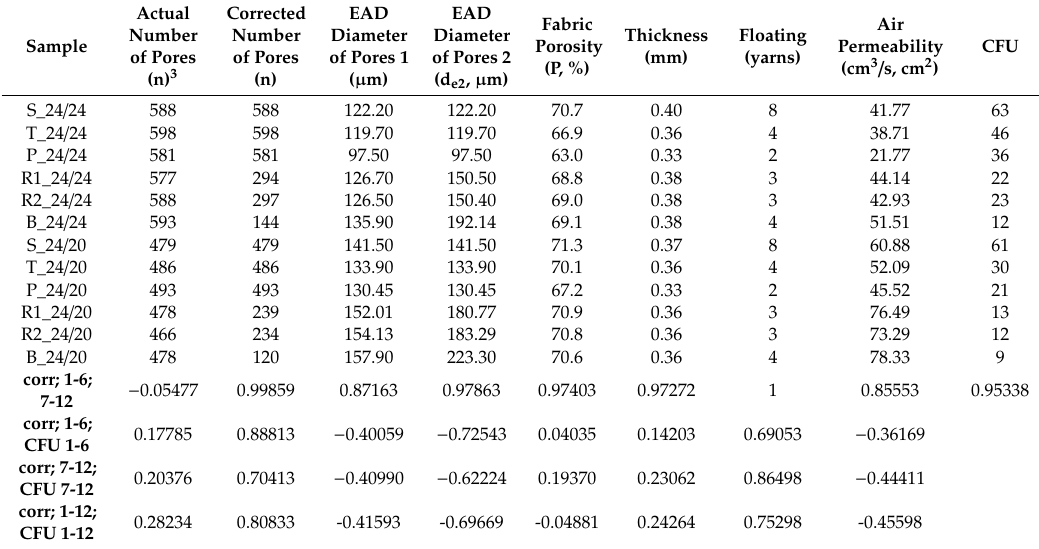
Table 7. Correlation values of individual fabric properties and the number of necessary rubbed bacteria for the passage of one unit with thread densities of 24 / 24 threads / cm and 24 / 20 threads / cm.